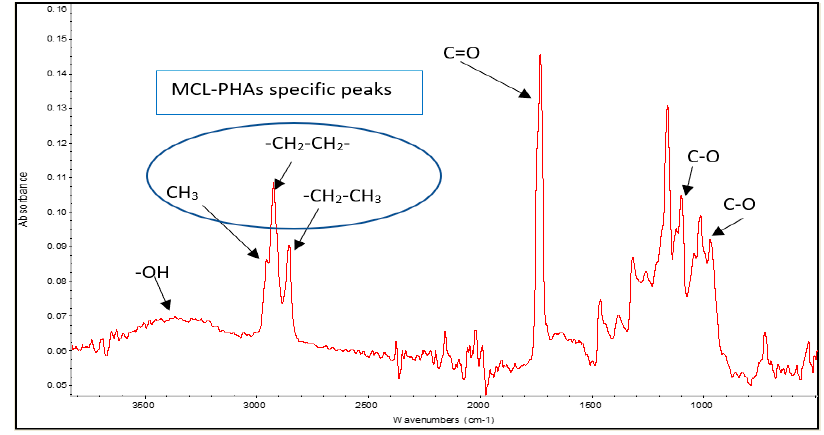
Figure 4. FTIR spectra of MCL-PHA sample.